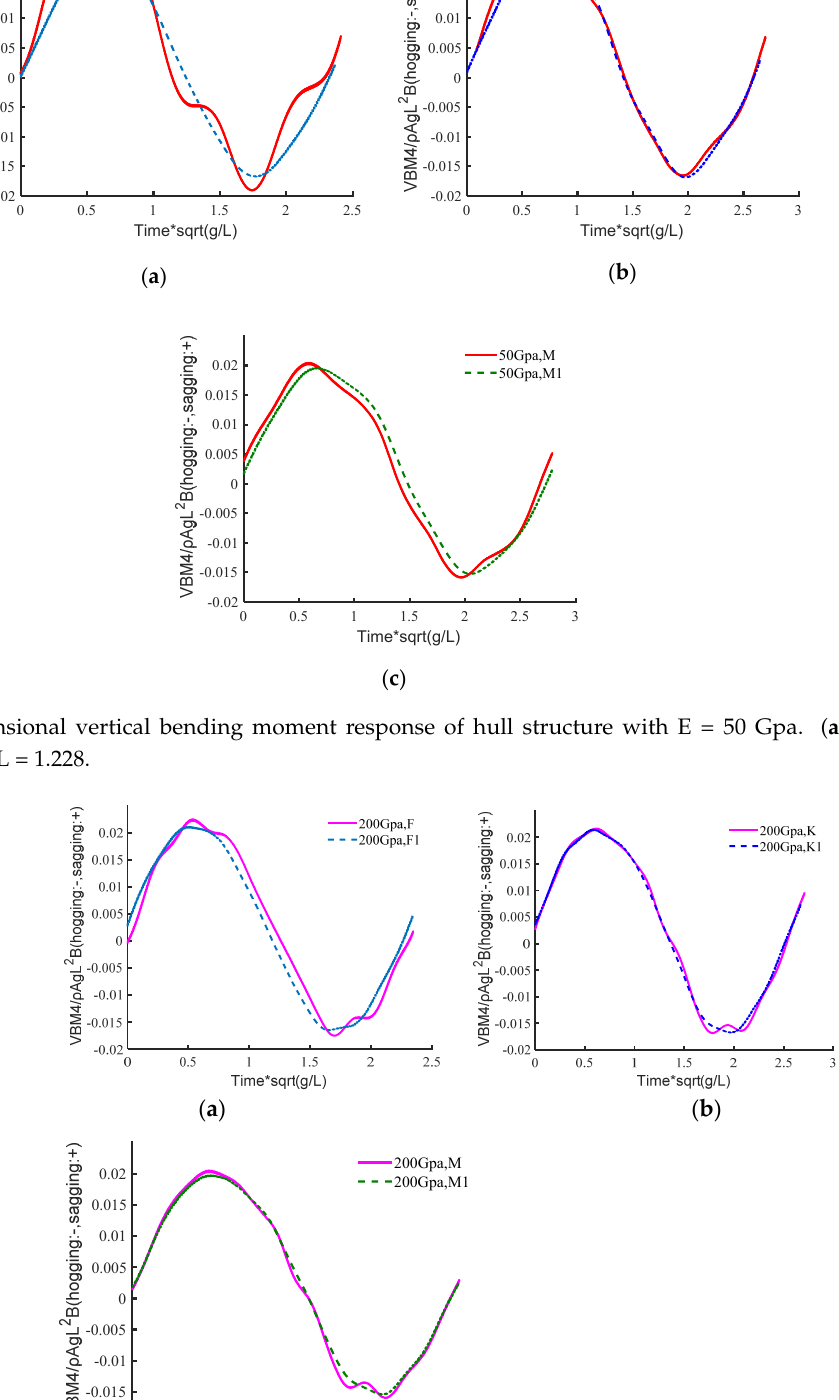
Figure 10. Non-dimensional vertical bending moment response of hull structure with E = 200 Gpa. ( a ) λ /L = 0.857; ( b ) λ /L = 1.070; ( c ) λ /L = 1.228.